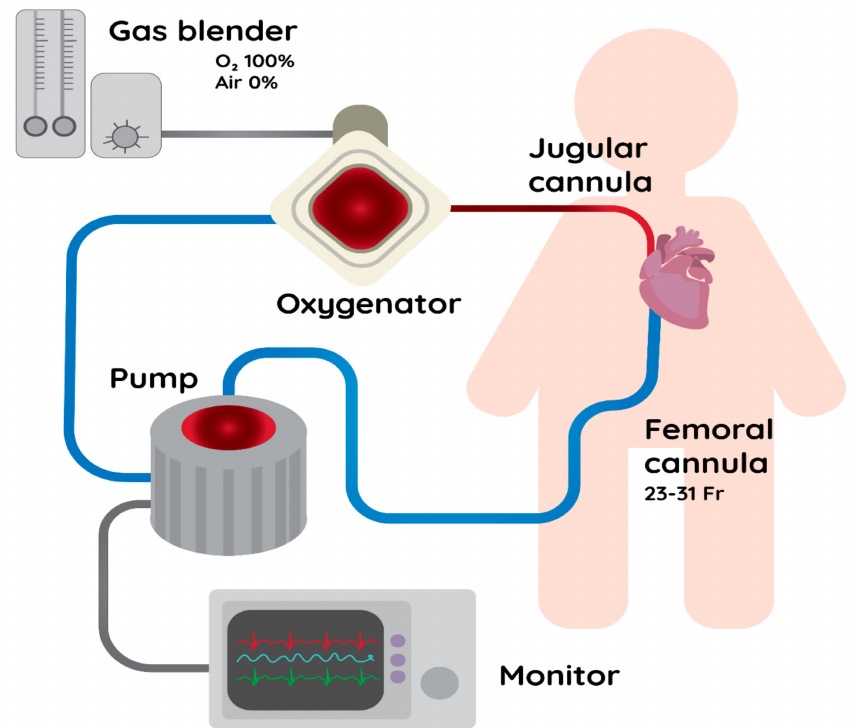
Figure 1. A scheme of the VV-ECMO circuit. VV-ECMO– Venovenous Extracorporeal Membrane